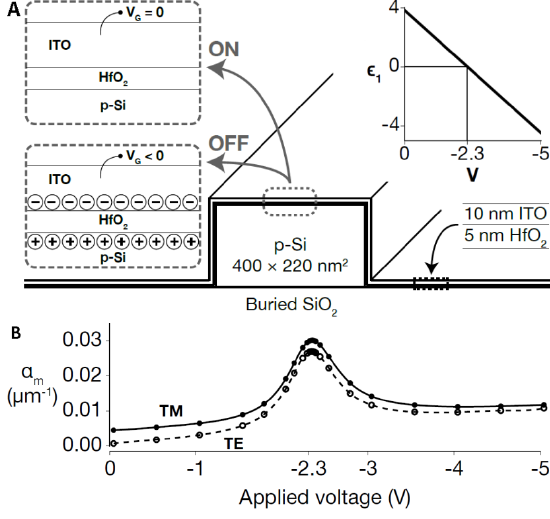
Figure 14: (A) One of the simplest yet eflcient structures includes only two additional layers (HfO 2 and ITO). Inset: real part of the TCO permittivity in the accumulation layer (approximately 1 nm) under different voltage. (B) Absorption coeflcient reaches maximum at the ENZ point. Copyright (2013), OSA, from Ref. [140], with permission of the authors. ENZ: Epsilon-near-zero; ITO: Indium tin oxide;